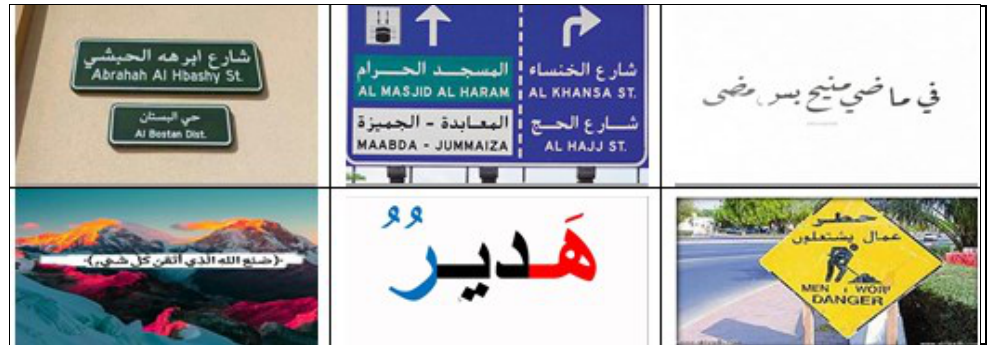
Fig. 4. Formed dataset samples